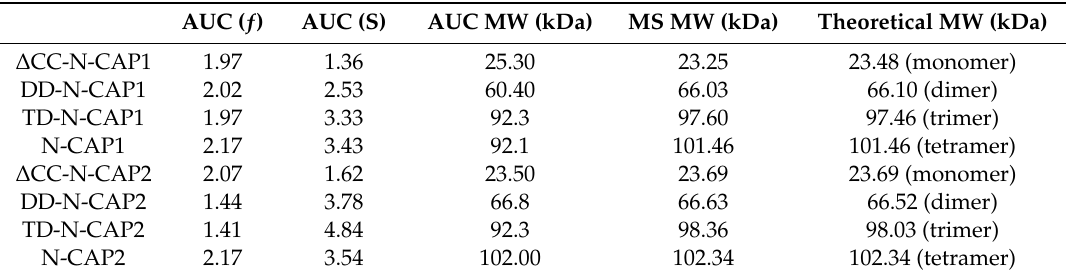
Table 1. Molecular weights (MW) of recombinant CAP constructs determined by SV-AUC and native MS. (ƒ) —frictional ratio; (S)—sedimentation coe ffi cient.